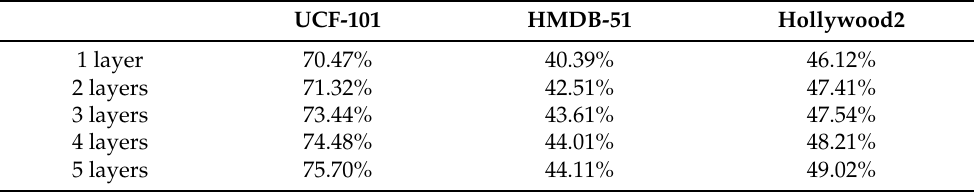
Table 2. The accuracy comparison of stacked ST-D LSTM units with different layers.